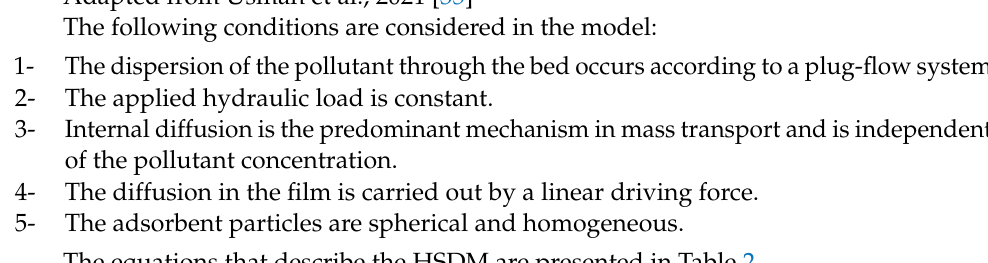
Table 2. Equation for the Homogeneous Surface Diffusion Model. Adapted from Roy et al., [51]. Equation Role